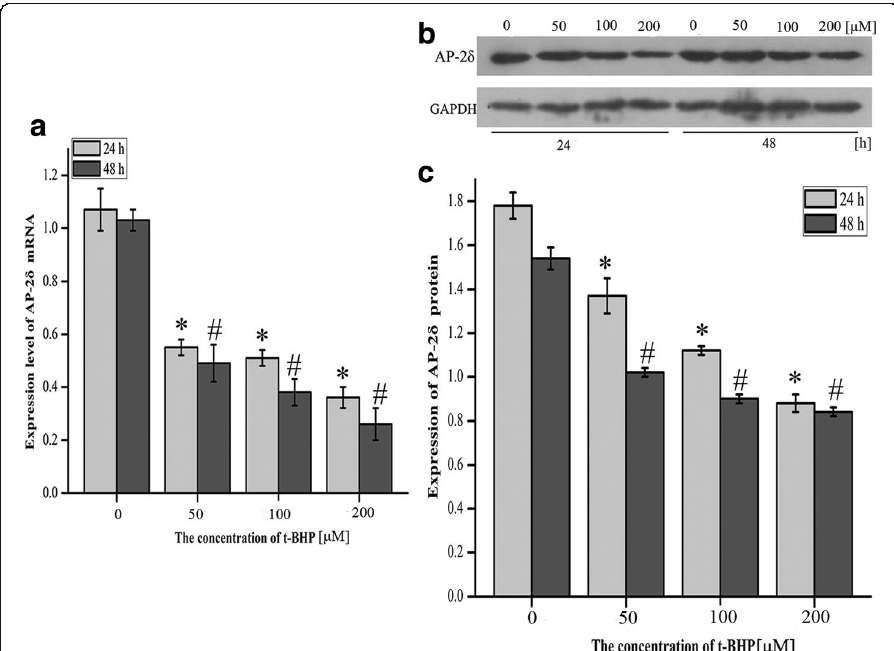
Fig. 6 Expression level of AP-2 δ in HEI-OC1 cells treated with t-BHP for 24 h and 48 h. a Expression level of AP-2 δ mRNA in HEI-OC1 cells exposed to different concentrations of t-BHP (0 μ M, 50 μ M, 100 μ M, 200 μ M) for 24 h and 48 h. b Representative western blot of AP-2 δ from cells treated with t-BHP. GAPDH was used as an endogenous control. These images came from the same gel. c Expression level of AP-2 δ protein in HEI-OC1 cells exposed to t-BHP. The data were normalized to GAPDH expression, and they were presented as the means±SD; n = 3 each group. * and # represent P < 0.05 compared with the control